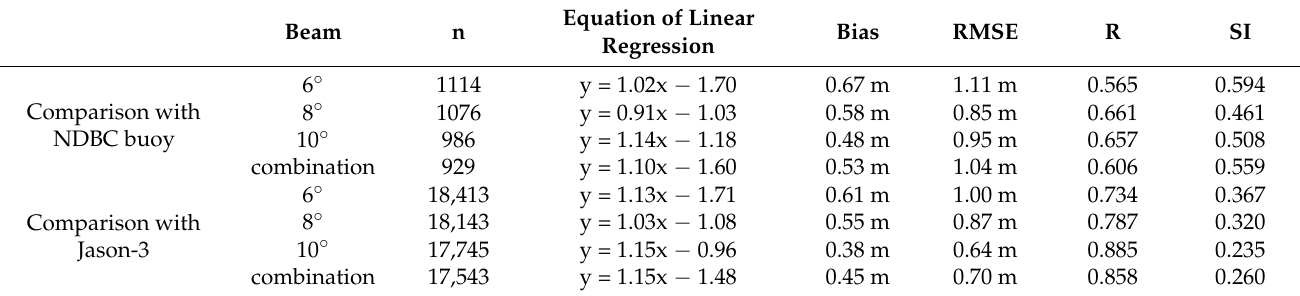
Table 1. Error parameters of off-nadir SWH data after linear regression